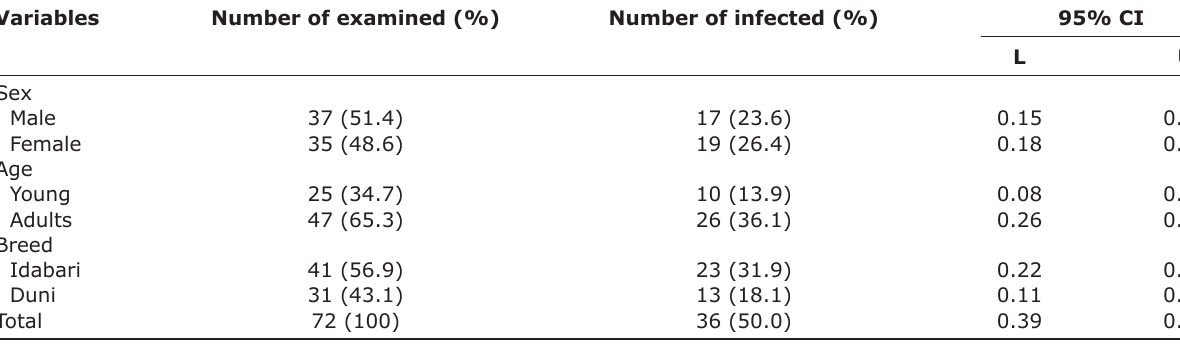
Table-1: Prevalence of nematodes infection in slaughtered donkeys.